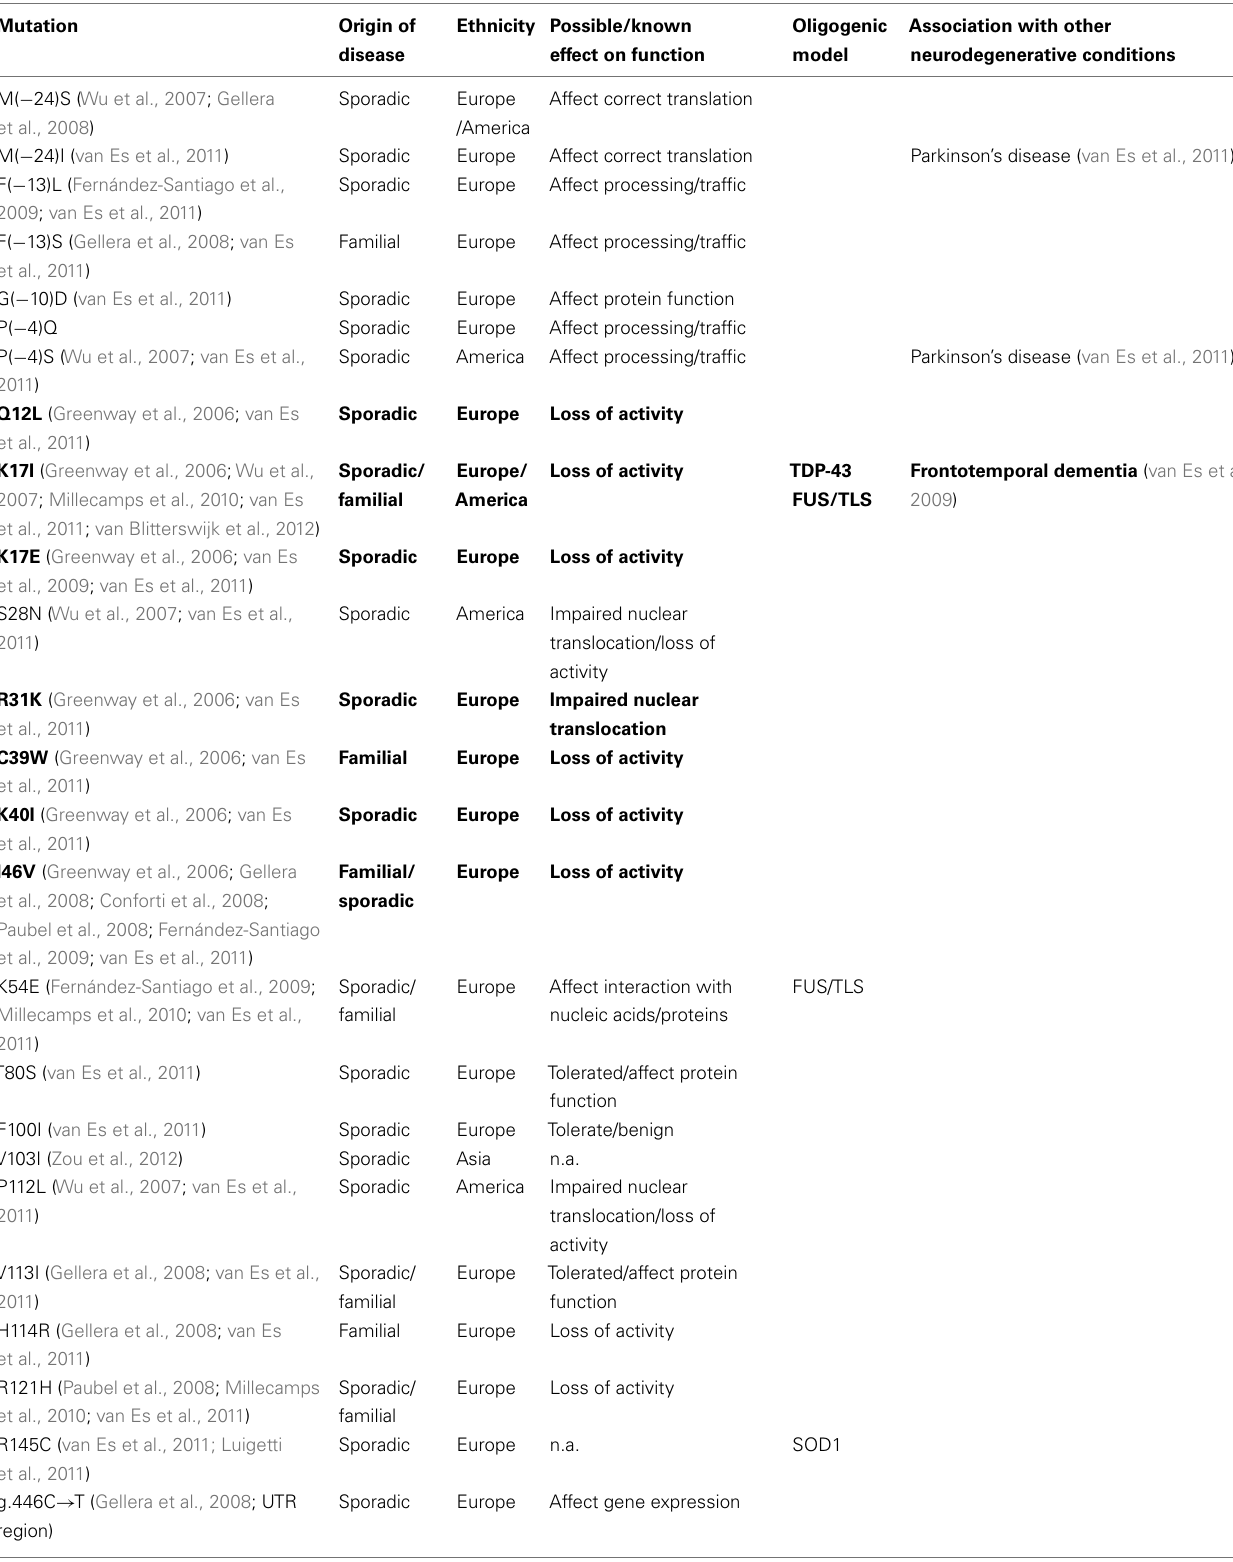
Table 1 |Angiogenin mutations associated